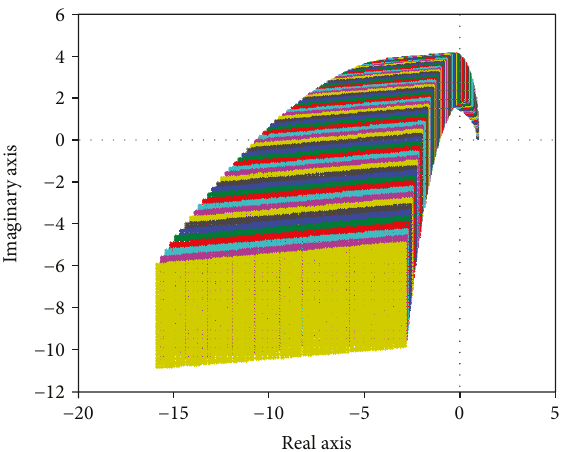
Figure 5: Value sets of FO interval polynomial (23) — gridding [55].